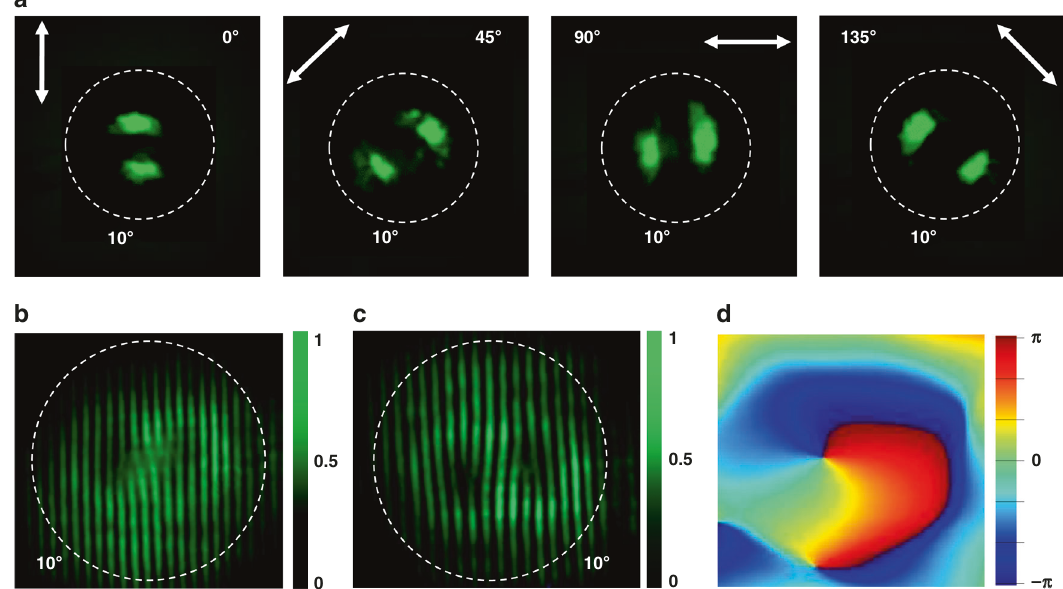
Fig. 4 The far fi eld characteristics of the Archimedean VCSELs. a The polarization states of the laser beam. The divergence angle are marked with dashed lines. b , c The measured self-interference patterns of the laser beams in the forward direction and in the backward direction, respectively. Here, the pump fl uence is 21 μ J/cm 2 . d The numerically calculated phase pro fi le of emission from the Archimedean spiral grating. The white dashed lines represent the angle of